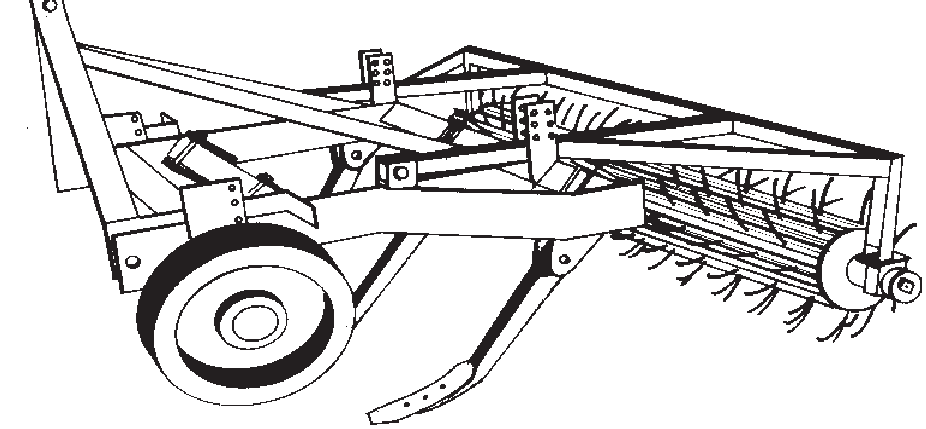
Figura 1. Escarificador jumbo AS 5/5, equipado com cilindro destorroador de